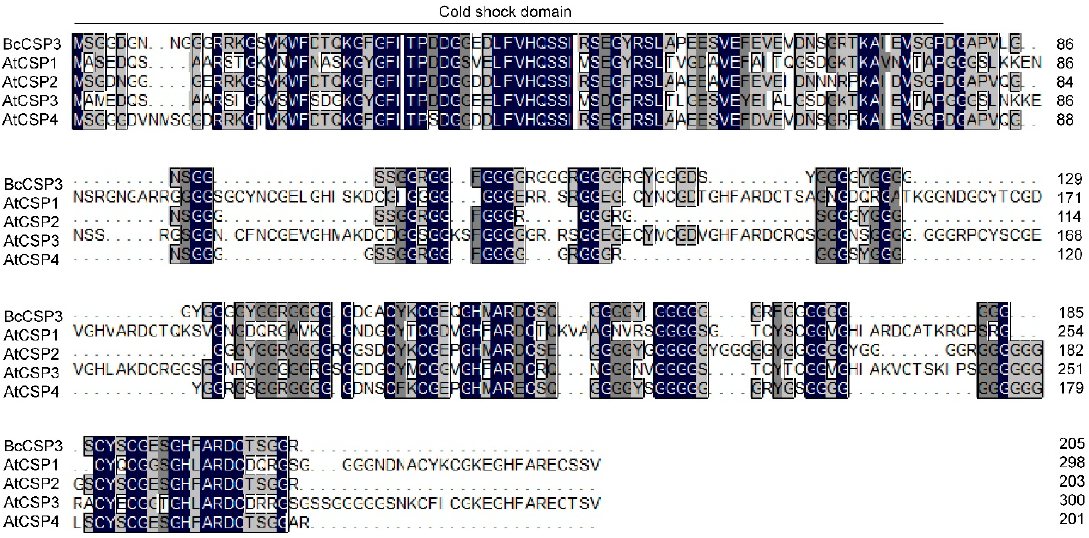
Figure 4. Amino acid sequence alignment of the putative BcCSP3 protein with Arabidopsis CSP proteins. Perfectly matched residues, highly conserved residues, and less conserved residues are represented by a black, dark gray and gray box, respectively.